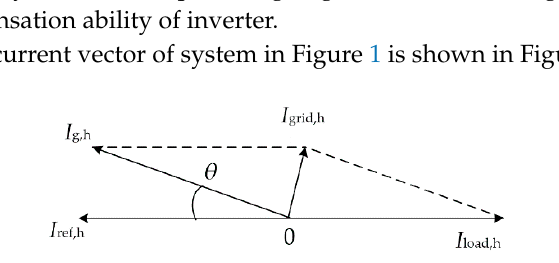
Figure 6. Diagram of current vector relationship.